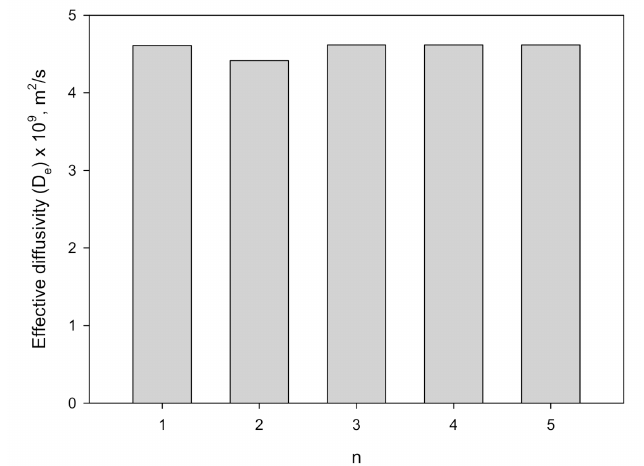
Figure 14. Typical effect of number of terms (n) in the summation solution of Equation (5) on the calculated effective diffusivity (De) of AC2-5 carbon